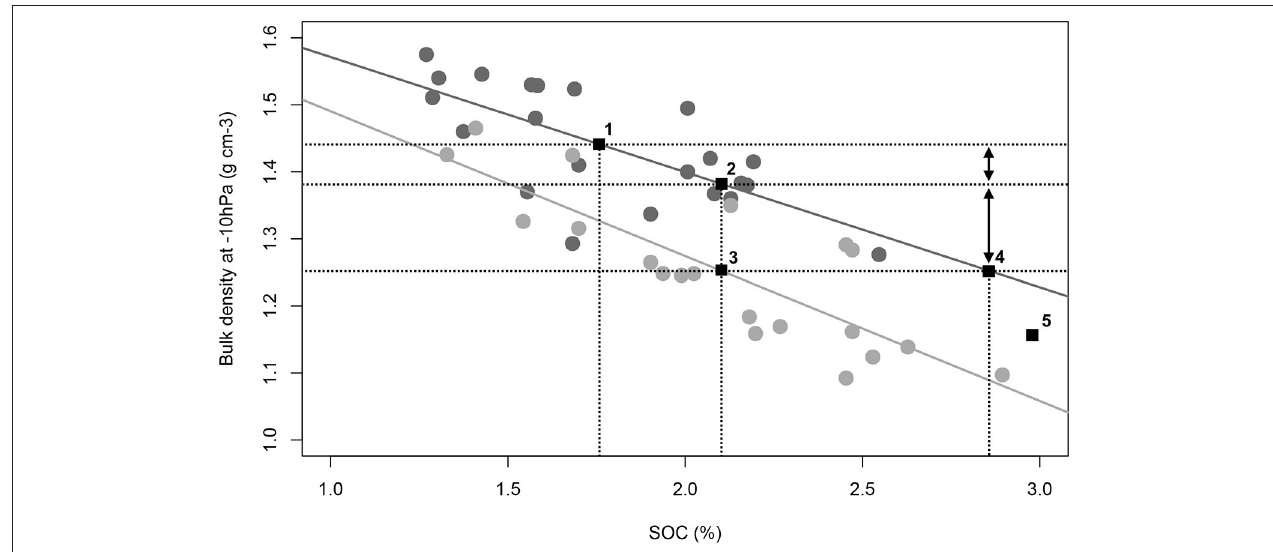
FIGURE 5 | Changes in soil bulk density in the 5–10cm layer during the experiment. Solid dark gray dots and line: observations at initial (trafficked) state and corresponding linear regression (trafficked soil). Solid light gray dots and line: observations final (remediated) state and linear regression (remediated soil). Solid square 1: average initial state. Solid square 2: final average SOC content and corresponding bulk density according to the trafficked SOC-bulk density relationship. Solid square 3: average final state. Solid square 4: final observed bulk density and corresponding SOC content on the trafficked SOC-bulk density relationship. Solid square 5: reference condition (neighboring permanent ungrazed pasture). Distinction of the effects of SOC increase (from solid square 1 to 2) and cover-crop (from solid square 2 to